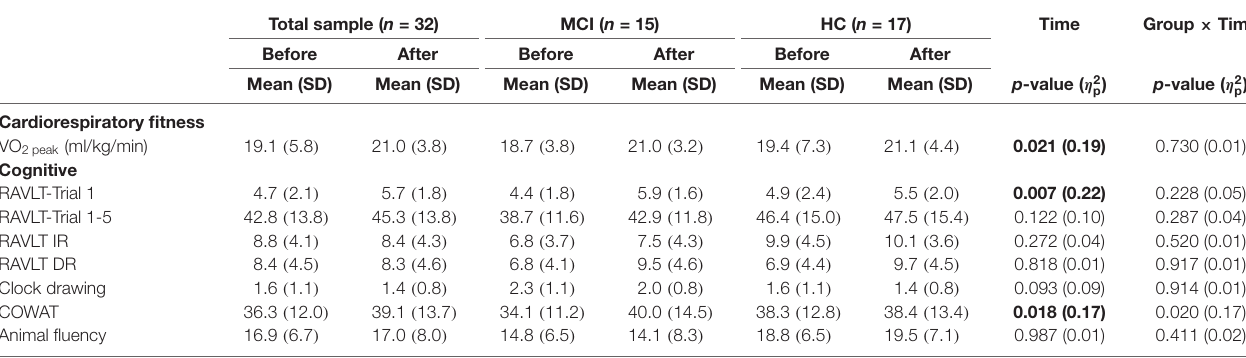
TABLE 3 | Significant mean diffusivity values for the Group, Time, and Group × Time voxel-wise analysis clusters. Cluster Cluster region Peak location Group × Time Interaction 1